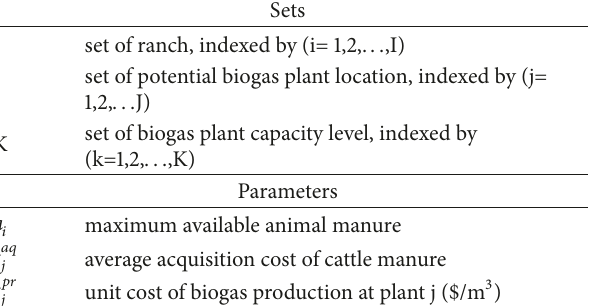
Table 1: Notations used in model